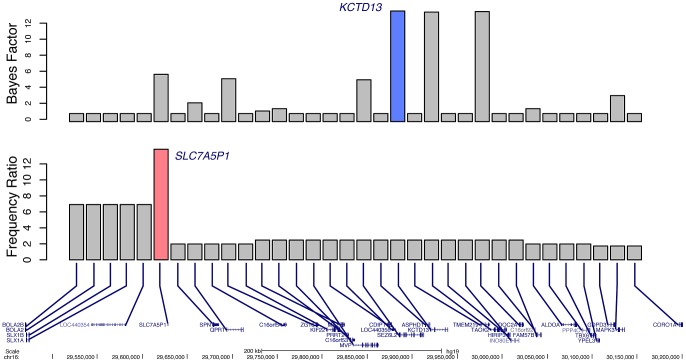
Prioritization of candidate genes at the 16p11.2 locus. Bottom. 34 RefSeq genes located within the 16p11.2 recurrent deletion. Middle. Ratio of deletion frequency of subjects with epilepsy to those referred for non-neurologic indications for each gene. The gene with the highest calculated ratio, SLC7A5P1, is highlighted in pink. Top. Bayes factors for each gene; the highest scoring gene, KCTD13, is highlighted in blue.